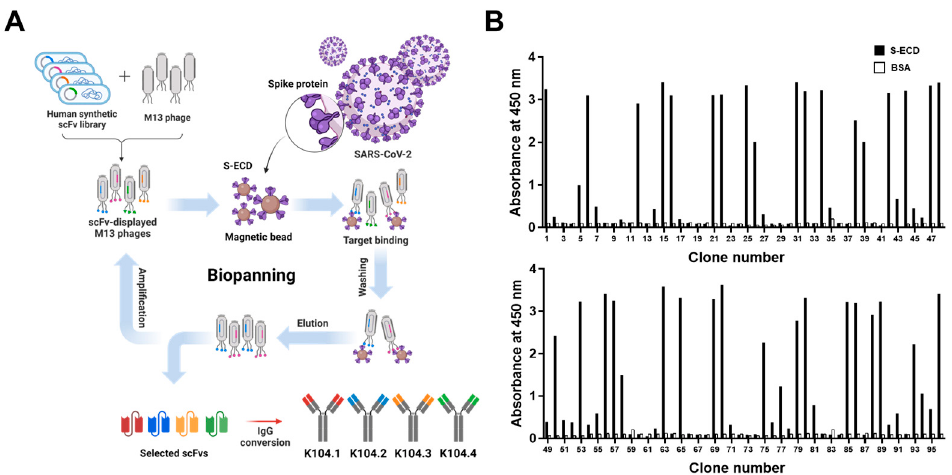
Figure 1. Isolation of severe acute respiratory syndrome coronavirus-2 (SARS-CoV-2) spike protein- specific IgG-based monoclonal antibodies (mAbs). ( A ) Schematic representation of the selection and preparation of SARS-CoV-2 spike protein-specific mAbs. Biopanning based on phage display technology using immobilized magnetic beads of SARS-CoV-2 extracellular domain of S protein (S-ECD) was used to select four SARS-CoV-2 spike protein-specific single-chain variable fragments (scFvs) from a synthetic scFv library, which were then converted to IgG-based mAbs (K104.1–K104.4). ( B ) The SARS-CoV-2 S-ECD-specific binding ability of ninety-six clones randomly selected after the four rounds of biopanning was determined using phage enzyme-linked immunosorbent assay (ELISA). Bovine serum albumin (BSA) was used as the negative